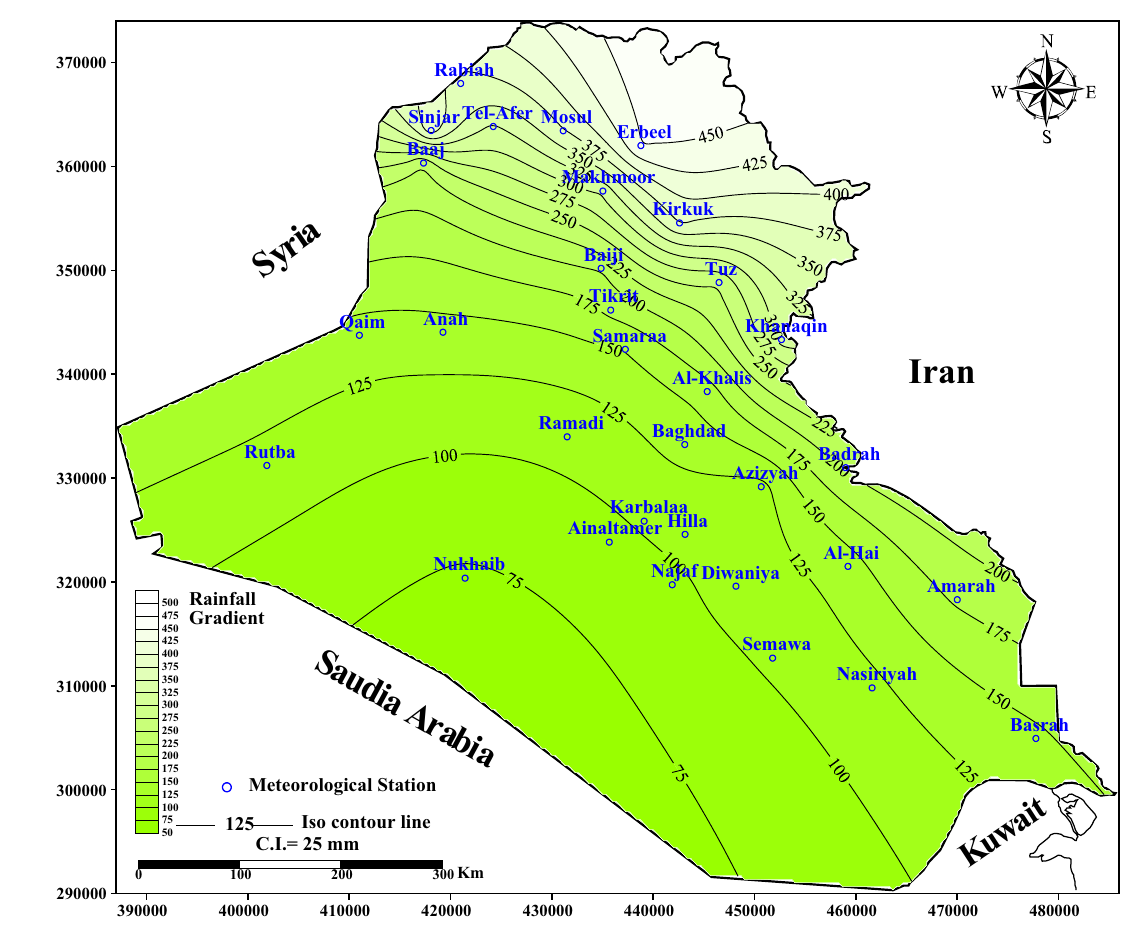
Fig. 2 Contour map of annual summation of rainfall in